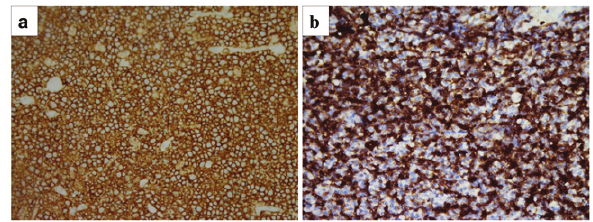
Figure 1: CD5 and CD43 expression in DLBCL patients (×40). a: CD5 positive expression in DLBCL patients; b: CD43 positive expression in DLBCL